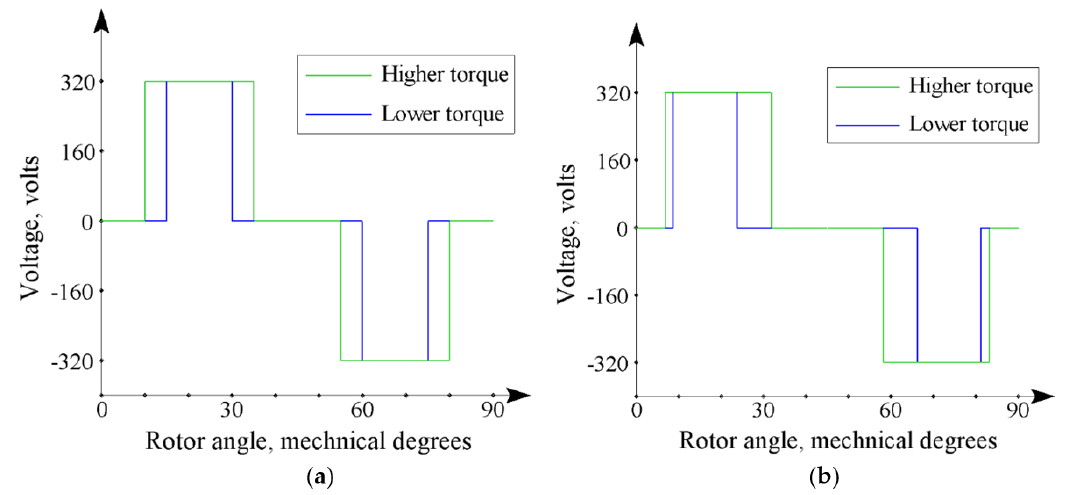
Figure 2. Supply voltage waveform: ( a ) basic case; ( b ) shifted pulses.